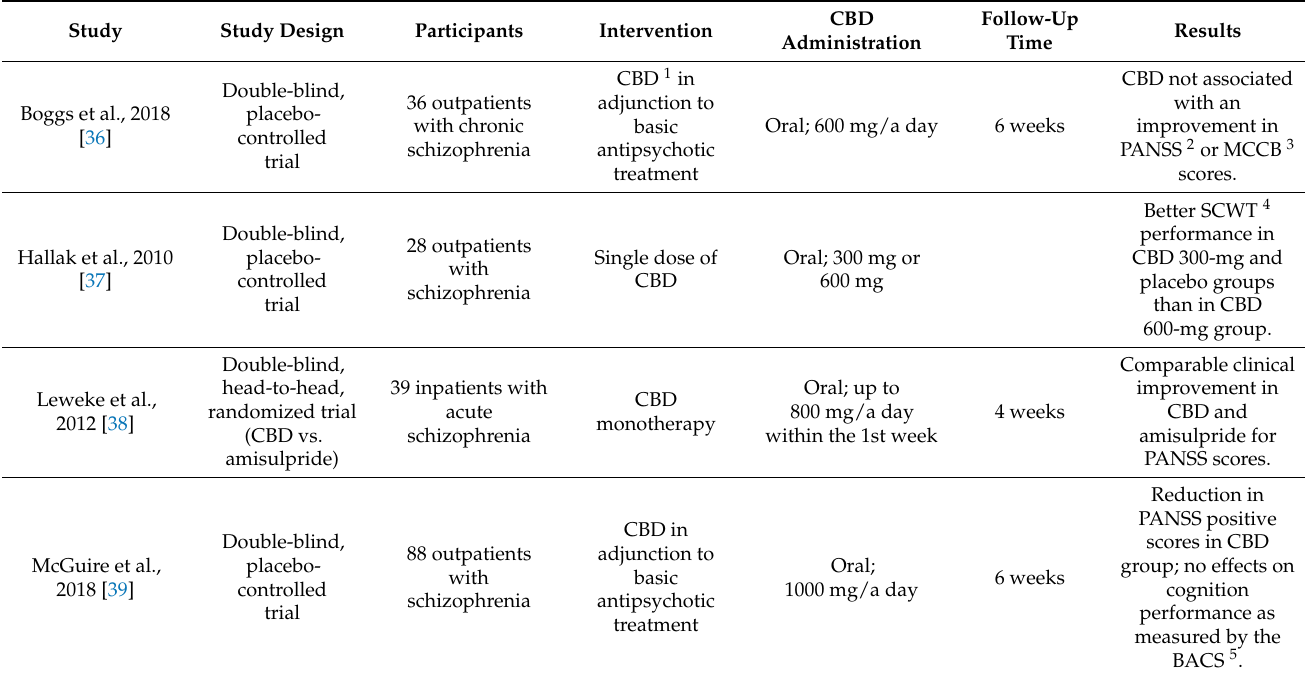
Table 2. Clinical trials testing Cannabidiol as a treatment for schizophrenia spectrum